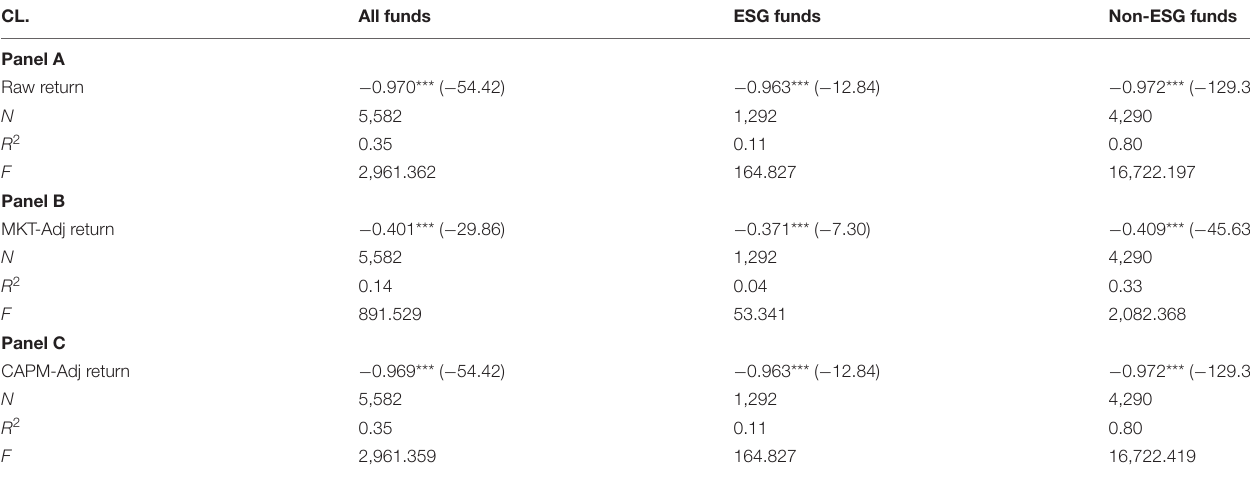
TABLE 2 | Fund flow–performance sensitivity comparison. CL.